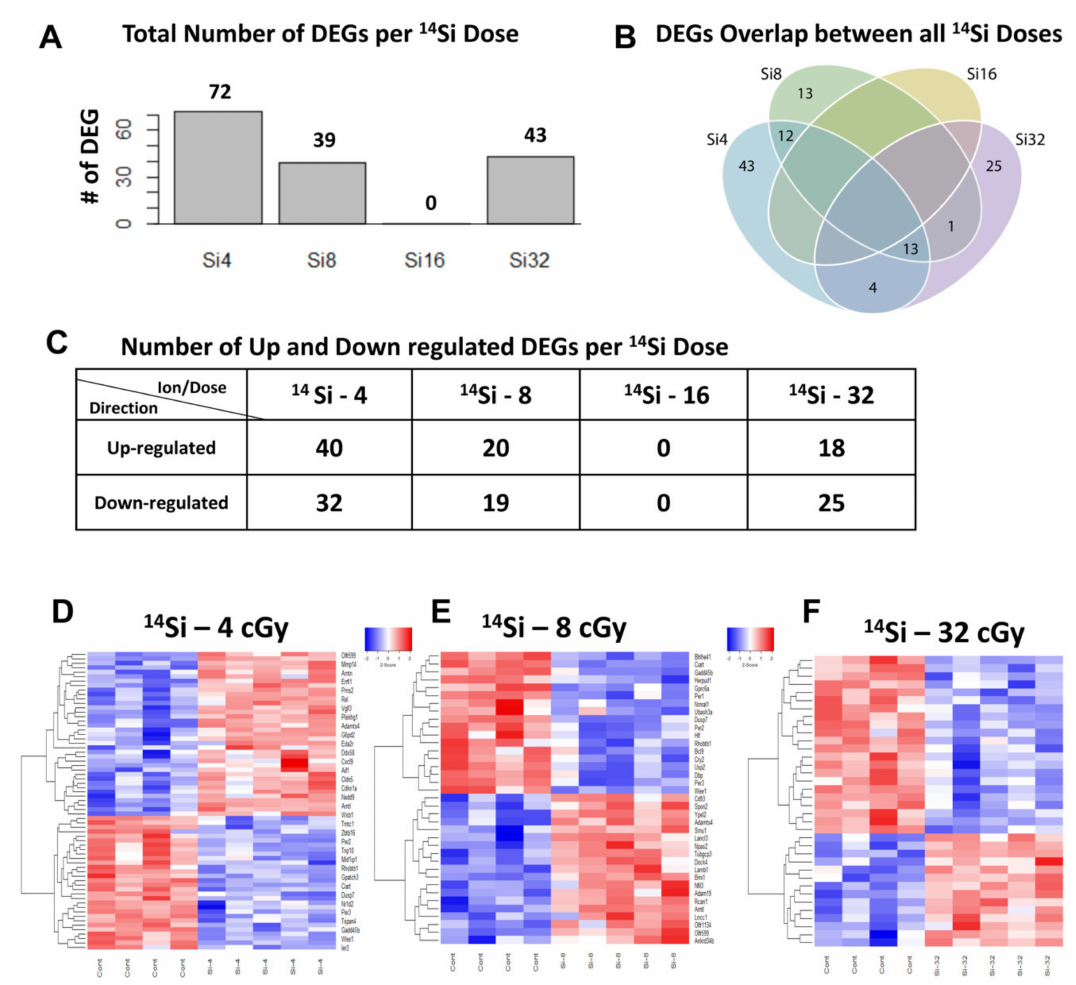
Figure 2. Different gene expression in mouse heart tissue following 14 Si irradiation: ( A ) bar graphs showing differentially expressed genes in mouse heart tissue after exposure to different 14 Si (Si, silicon) doses and ( B ) Venn diagram depicting the number of differentially expressed genes in mouse hearts across different doses of 14 Si irradiation exposure. Colors in the diagram represent genes putatively affected by the following 14 Si dose exposure: blue circles correspond to 4 cGy, green circles to 8 cGy, yellow circles to 16 cGy, and purple circles to 32 cGy. ( C ) Table depicting the number of up- and downregulated genes at different 14 Si-IR doses in the heart tissue and ( D – F ) heat maps showing differentially expressed genes at different 14 Si-IR oses. Relative expression values are indicated on the color key and increase in value from blue to red ( n =